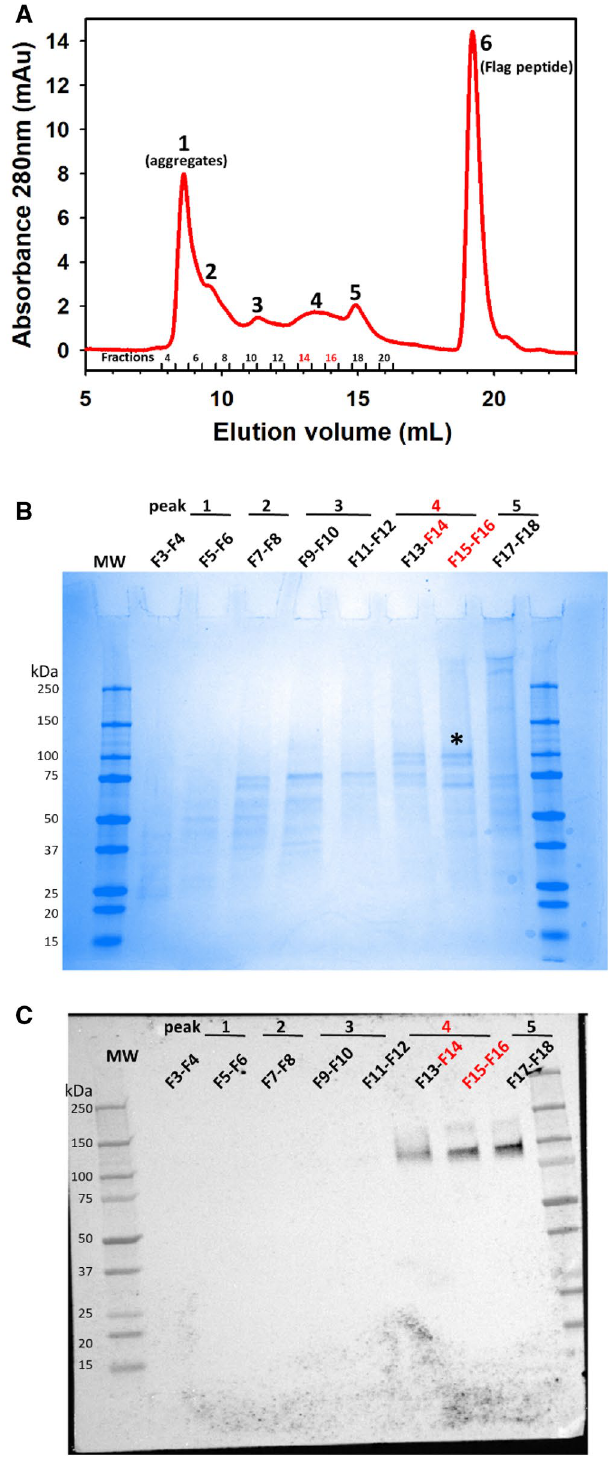
Figure 5. Size exclusion chromatography of immunoaffinity-purified hTAS1R2. ( A ) SEC analysis was performed on an Akta Pure FPLC system equipped with a Superdex 200 Increase 10/300GL column (GE Healthcare). Immunoaffinity-purified hTAS1R2 was eluted using PBS-LMNG 0.1% (pH 7.3). Six distinct peaks were observed, suggesting the presence of several oligomeric forms of the protein. The peak fractions were analysed by ( B ) SDS-PAGE followed by staining with Coomassie blue and ( C ) by western blotting using mouse anti-FLAG M2 primary antibody and goat anti-mouse horseradish peroxidase conjugated secondary antibody. The peak and fraction numbers refer to those designated in ( A ). Peak 4 (fractions 14–16) contained mainly hTAS1R2 marked with a black